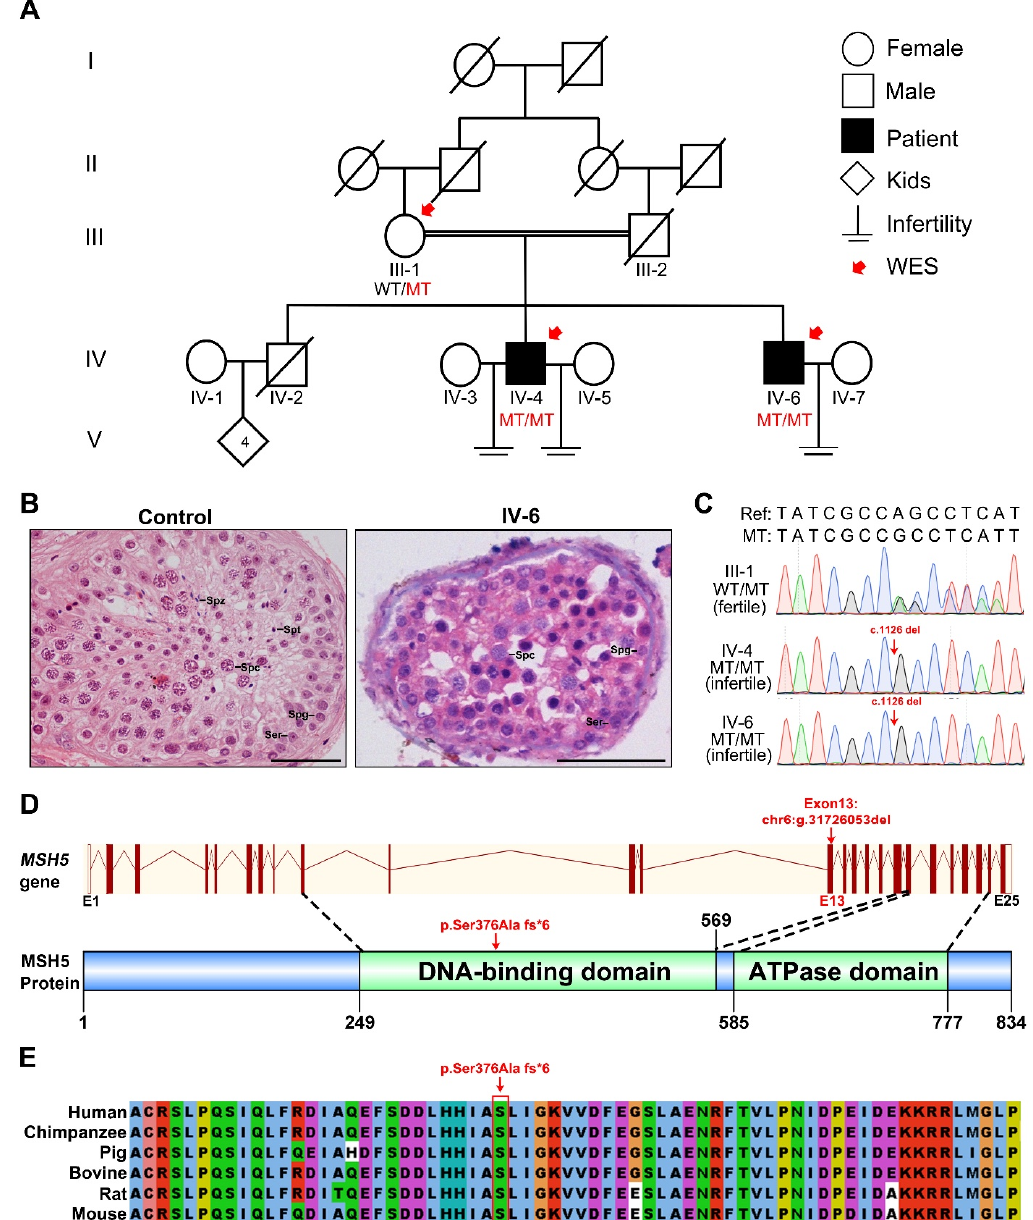
Figure 1. Identification of a homozygous MSH5 mutation in the NOA individuals. ( A ) A consan- guineous Pakistani family with two NOA individuals. WES was performed on members pointed by the red arrows. Double horizontal lines represent consanguineous marriages. Squares and circles denote male and female members, separately. Solid symbols indicate the infertile males, and open symbols denote unaffected members. Slashes represent deceased family members. ( B ) Testicular histological analyses of a male control with OA and the patient IV-6 by H&E staining. Spg, sper- matogonia; Spc, spermatocyte; Spt, spermatid; Spz, spermatozoa; Ser, Sertoli cell. Scale bars indicate 50 µ m. ( C ) Sanger sequencing chromatograms of the MSH5 variant of this pedigree. The red arrows indicate the mutation site. ( D ) Schematic map of the mutation position in MSH5 at the genomic and protein levels. The schematic gene structure was based on the Ensembl database (GRCh38, transcript ID: ENST00000375750.9). The red solid rectangles represent exons (exon 1 to 25), and the red lines represent introns. The schematic protein structure was based on the HPRD database (HPRD ID: 04544). ( E ) The conservation analysis of the MSH5 mutant amino acid across different